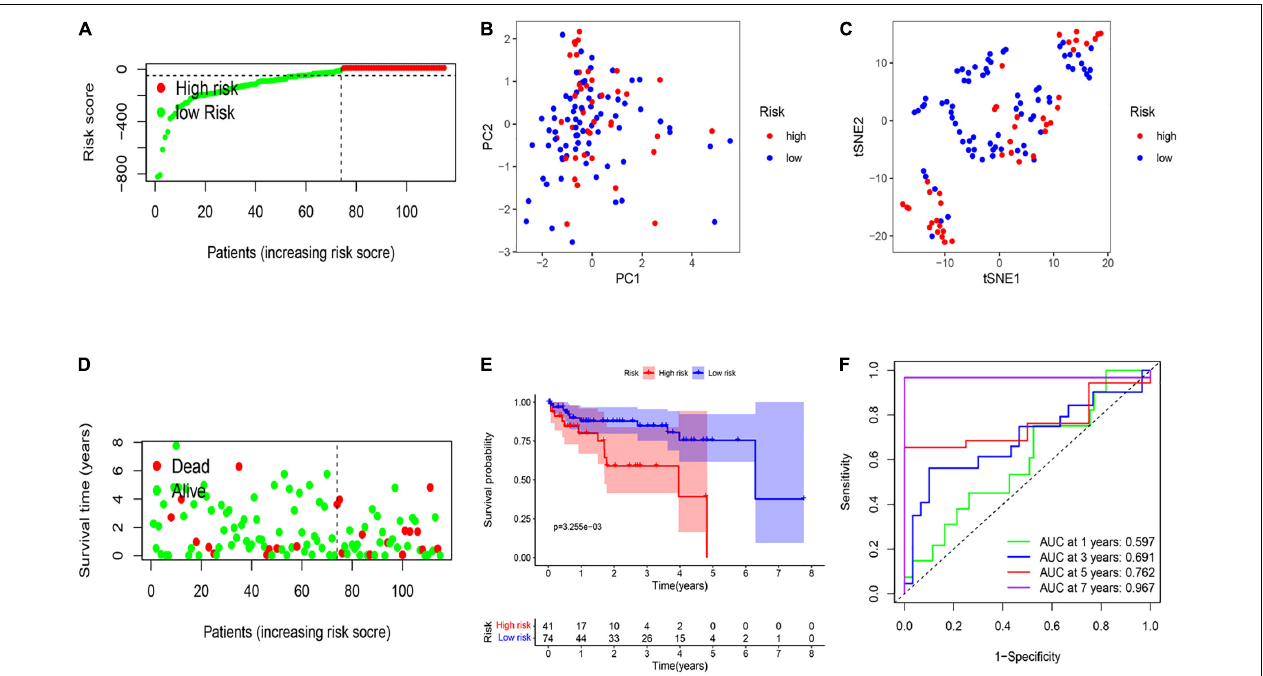
FIGURE 3 | External validation of the risk signature. (A) Risk score analysis of the six-PRG profile in the validation cohort. (B) PCA plot based on the risk score. (C) t-SNE analysis of the validation cohort. (D) The survival status analysis for each patient based on the risk score in the validation cohort. (E) Kaplan–Meier curve of low- and high-risk groups based on the six-pyroptosis-related gene profile. (F) Time-dependent ROC analysis for the 1-, 3-, 5-, and 7-year OS of the six-pyroptosis-related gene profile in the validation